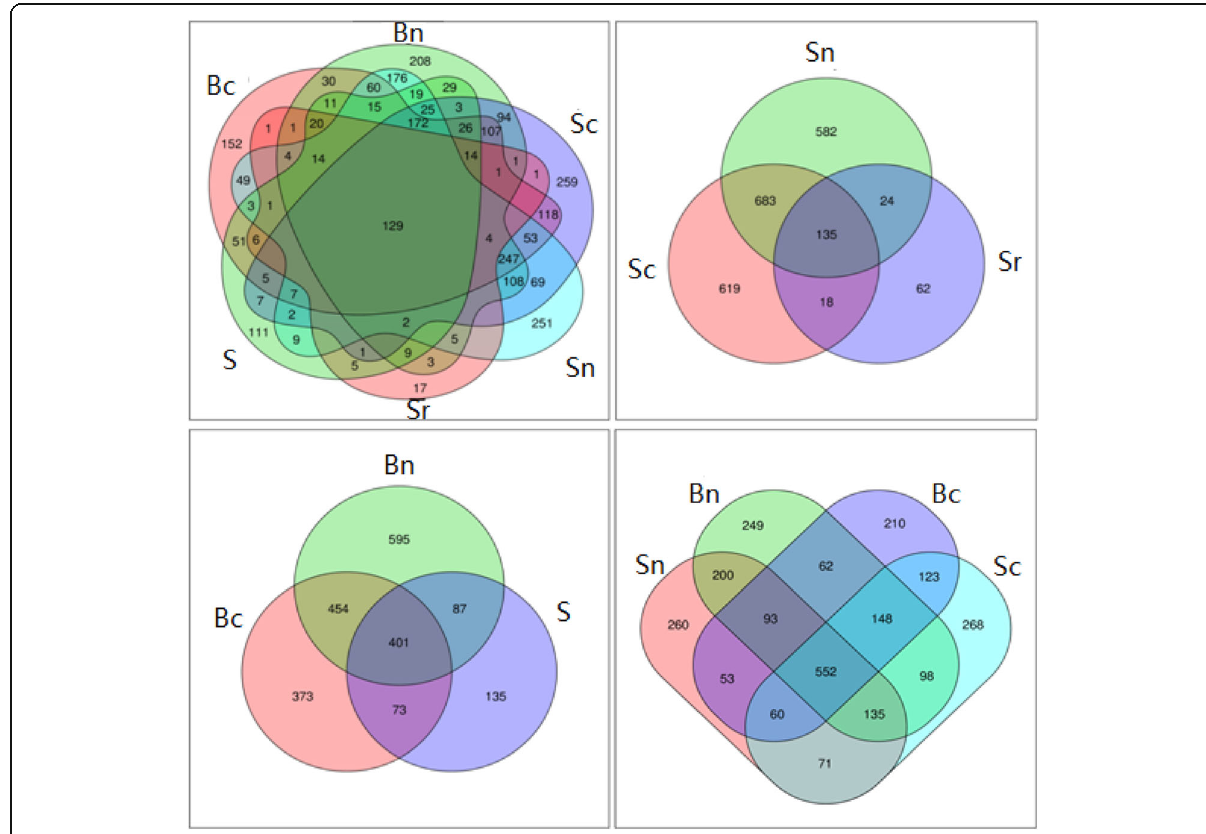
Fig. 3 Venn diagram of OTUs in all sugar beet and soil samples. Bc: sugar beet tuber of continuous cropping; Bn:sugar beet tuber of non- continuous cropping; Sc: soil of Bc; Sn: soil of Bn; Sr: rhizosphere soil of Bn; S: seeds of sugar